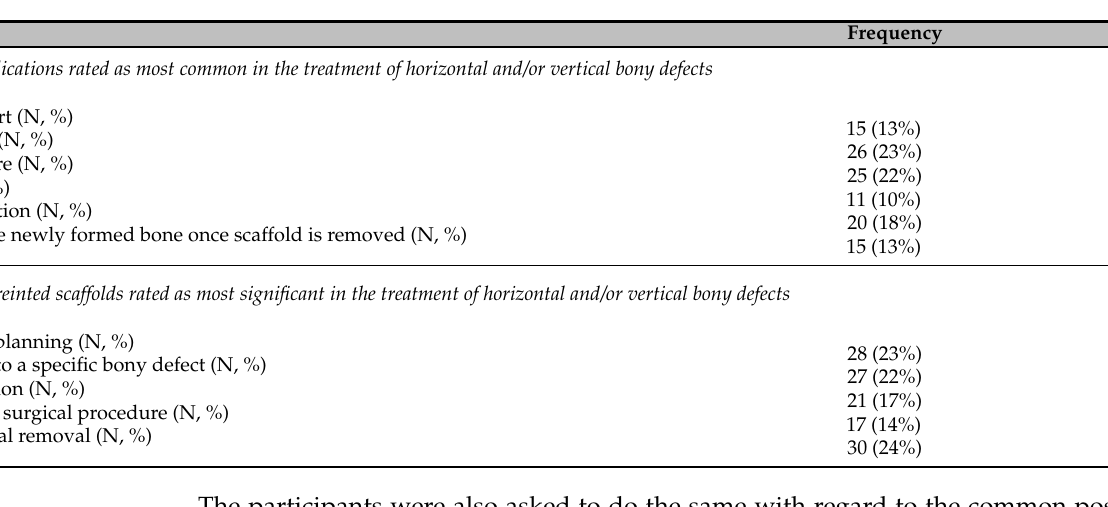
Table 2. Perceived advantages of biodegradable 3D-printed scaffolds and common post-operative complications with the use of scaffolds.